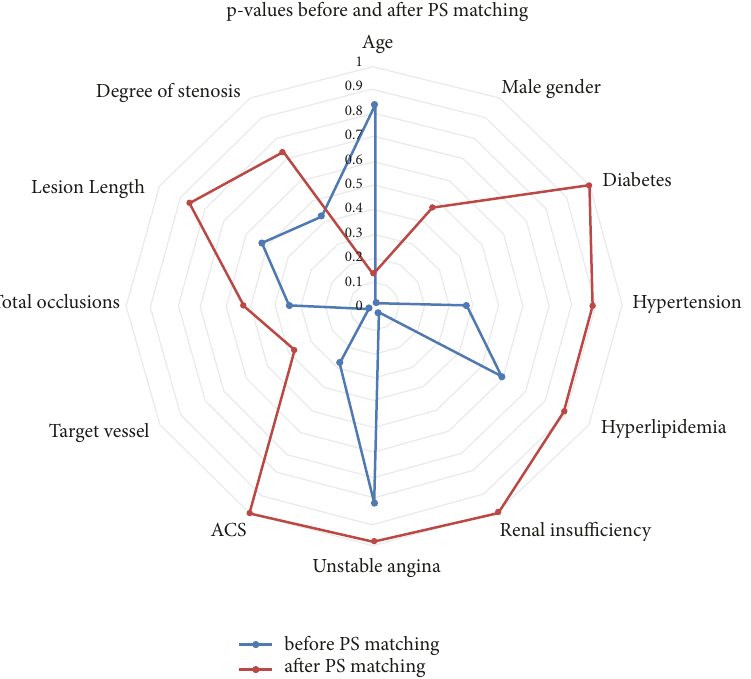
Figure 1: Demographic and lesion morphological characteristics before and after PS